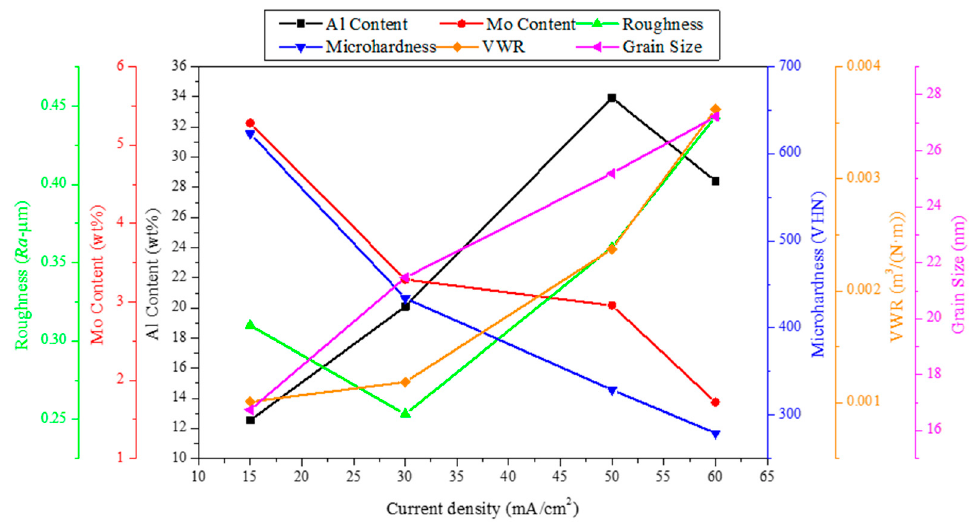
Figure 5. The effect of current density on the grain size, chemical composition, volumetric wear rate (VWR), microharness, and roughness properties of coatings obtained at the temperature of 40 °C, Al content in the bath of 5 g/L, stirring rate of 500 rpm, and different current densities.